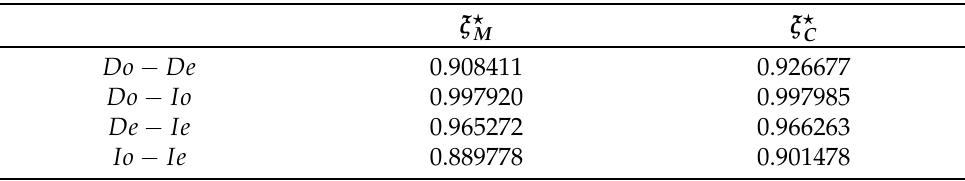
Table 6. Hypervolumes of the Pareto fronts returned by the multi-objective algorithm ξ (cid:63) compound criterion ξ (cid:63) , for each of the four considered C